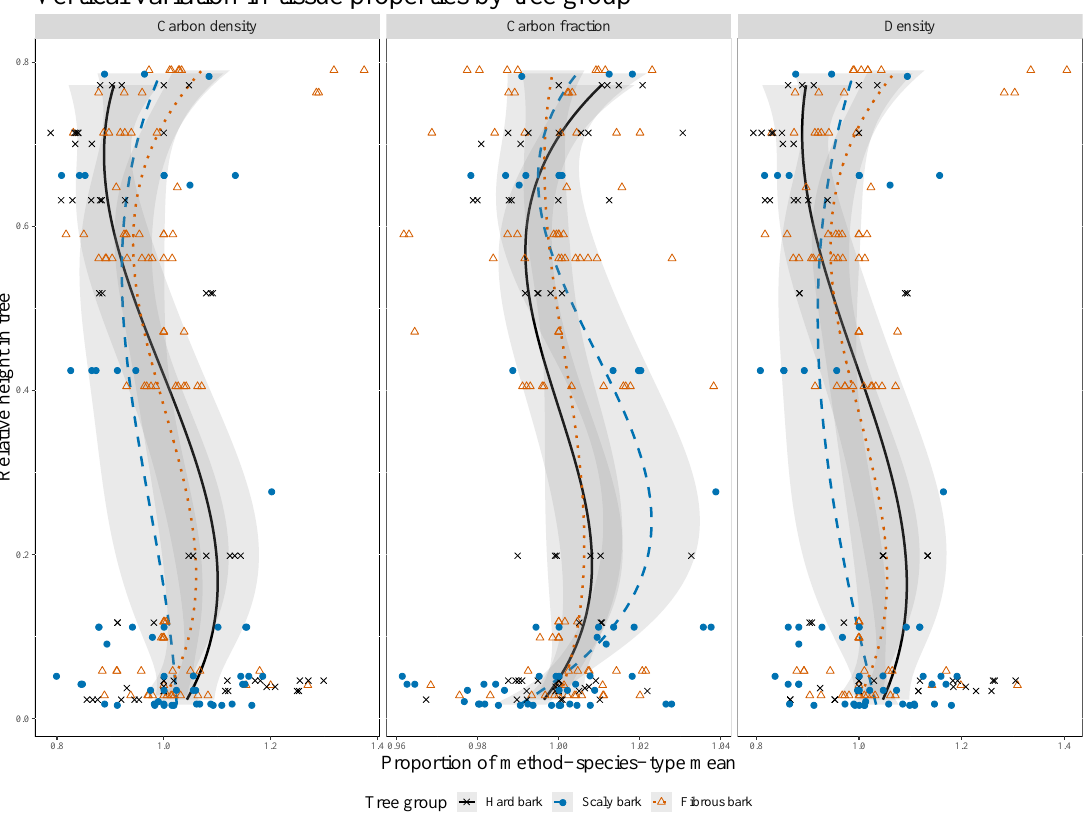
Figure 1. Fractions of species-tissue type averages across relative heights are shown. Species values are grouped into three bark characteristic categories: fibrous, scaly, and furrowed. LOESS regressions are shown for each tree group to demonstrate the moving average change in tree property throughout the tree